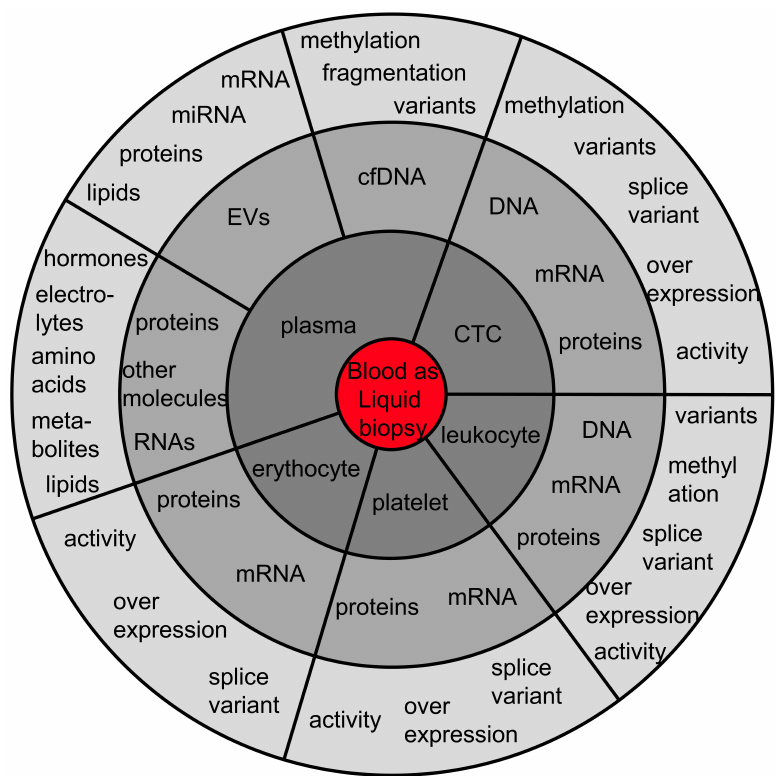
Figure 1. The diversity of liquid biopsy analytes in blood. The analytes can be separated into tumor cells, non-malignant blood cells and analytes within the plasma fraction. Not all of the mentioned analytes are tumor-derived/specific, but all analytes can provide information about the tumor-associated systemic changes mirrored in the blood stream. The authors do not guarantee completeness of the list of blood analytes usable as liquid biopsy reservoirs in oncology. Abbreviations: cfDNA: cell-free DNA; CTC: circulating tumor cell; EVs: extracellular